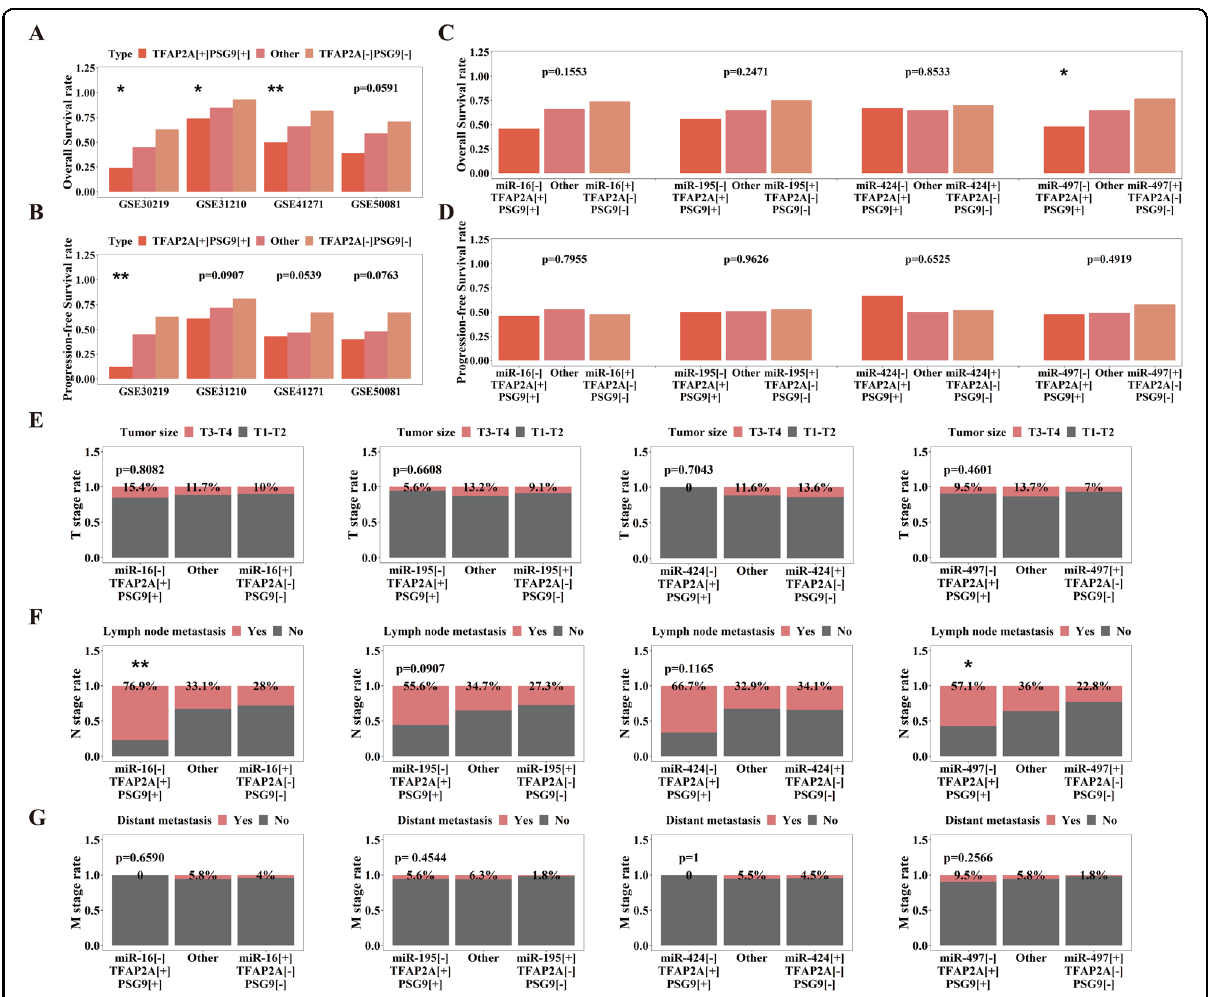
Fig. 7 The miR-16 family/TFAP2A/PSG9 axis exhibits clinical effects upon LUAD. A , B The effects of TFAP2A/PSG9 on survival rate in four independent LUAD datasets (GSE30219, GSE31210, GSE41271 and GSE50081) ( A , OS rate; B , PFS rate). C , D The in fl uence of miR-16 family/TFAP2A/ PSG9 upon survival rate in TCGA-LUAD dataset ( C , OS rate; D , PFS rate). E – G The in fl uence of miR-16 family/TFAP2A/PSG9 upon TNM parameters in TCGA-LUAD dataset ( E , T parameters: tumor size; F , N parameters: lymph node metastasis; G , M parameters: distant metastasis). * p < 0.05; ** p < 0.01; *** p <